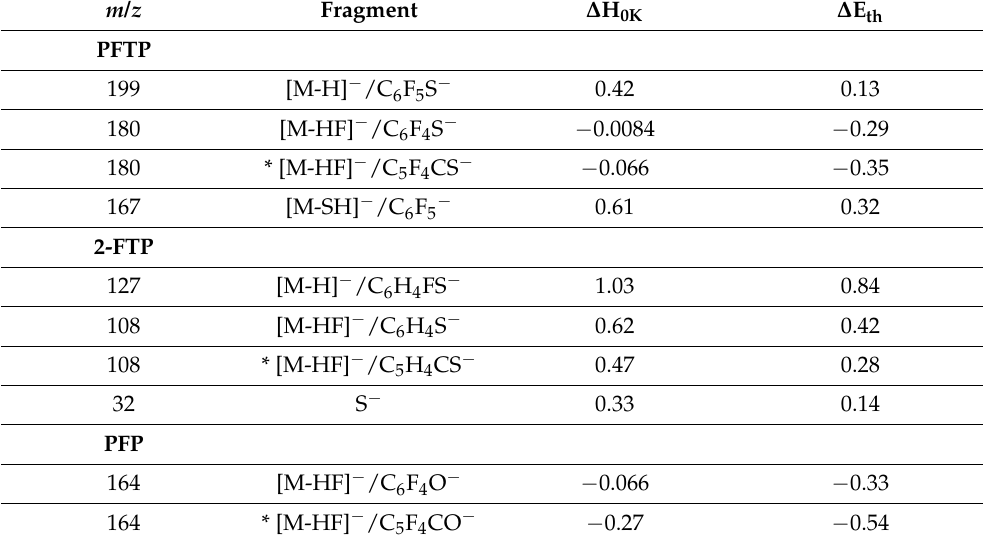
Figure 1. Left: DEA ion yield curves from PFTP for the channels: ( a ) H loss, ( b ) HF loss, and ( c ) SH loss. Right: DEA ion yield curves from 2-FTP for the channels: ( d ) H loss, ( e ) HF loss, ( f ) S − formation. The intensities are normalized with respect to the target gas pressure and the formation of SF 6 − from SF 6 at 0 eV incident electron energy.